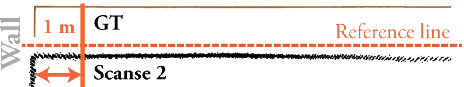
Figure 14. Profile view of a side wall showing deviations in the Scanse data. Using only the closest 1 m of adjacent surface avoided the influence of errors contained in the remainder of the Figure 11. Projections of Scanse 2 point cloud along the three coordinate planes. Only two were used for histogram analysis, shown in black.